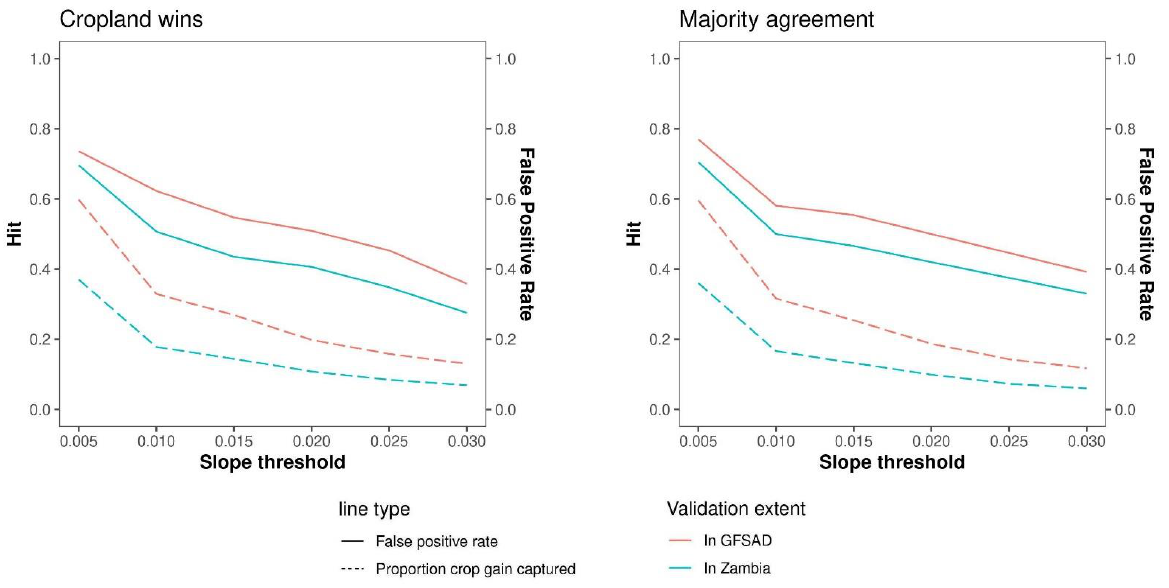
Figure 9. The percentage of actual cropland gain captured by the mapped cropland gain, as deter- mined by varying slope thresholds, along with the commission error (reference samples points that showed no cropland gain but were mapped as cropland gain by BULC-U for the reference sample transition class).